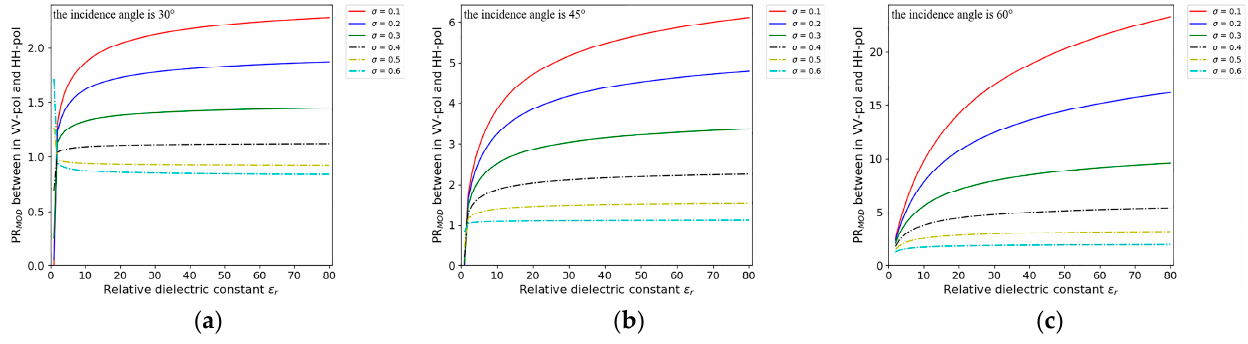
Figure 4. Numerical simulation of PR MOD . Incidence angles are ( a ) 30 ◦ , ( b ) 45 ◦ , and ( c ) 60 ◦ . The standard deviation 𝜎 of the orientation angle shift varies from 0.1 to 0.6 in steps of 0.1 [23].